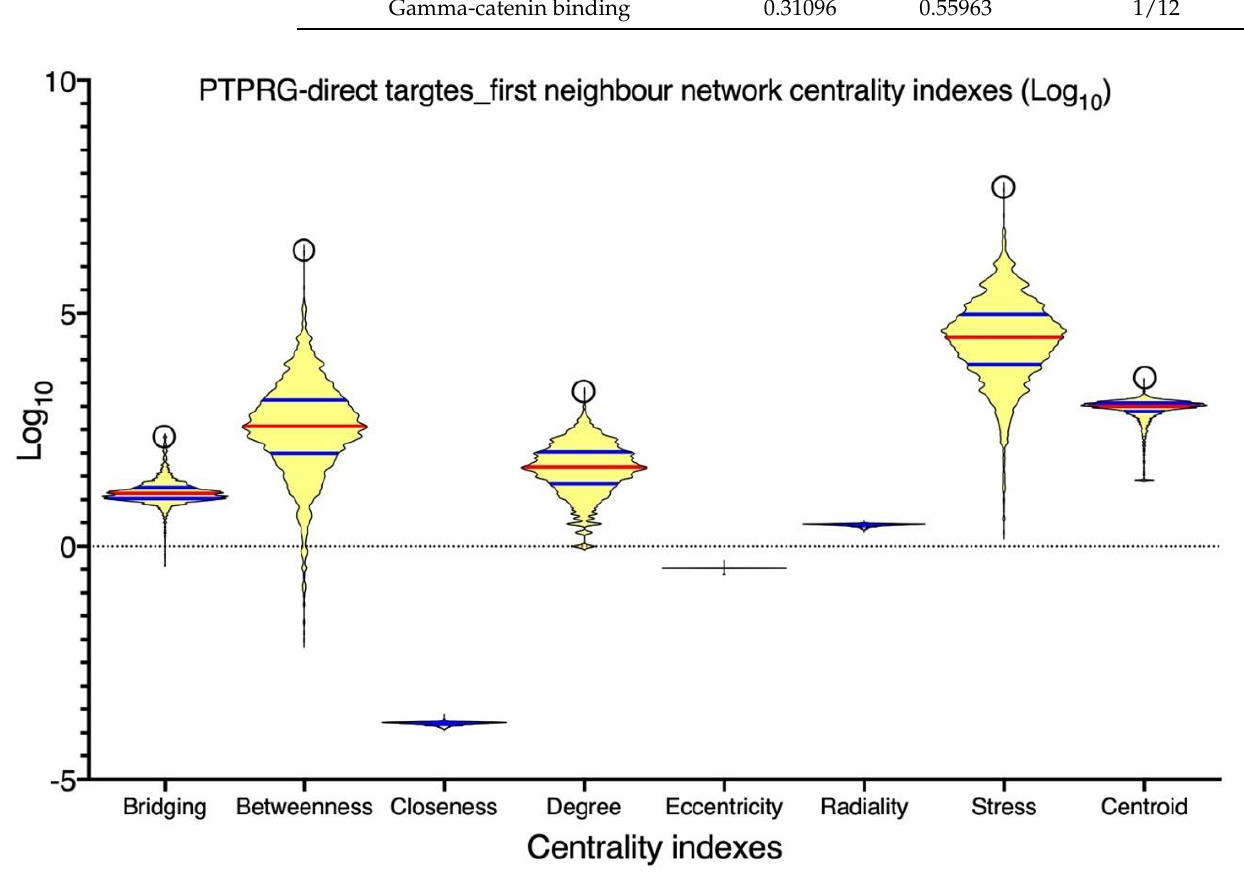
Figure 2. Node centrality indexes computational analysis of the first neighbor’s protein–protein interaction (PPI) network inferred upon the eight known PTPRG direct targets: JAK2, BTK, ABL1, AXL, CTNNB1, BCR, EGFR, and FGFR1. Shown are violin plots of the statistical distribution of the values of the different node centrality indexes calculated for every node (2976 nodes, connected by 123,961 non-redundant, un-directed edges). To allow direct comparison, the log10 for every value was calculated. The upper open circle indicates the position of PTPRG. Red lines are medians, blue lines are quartiles.